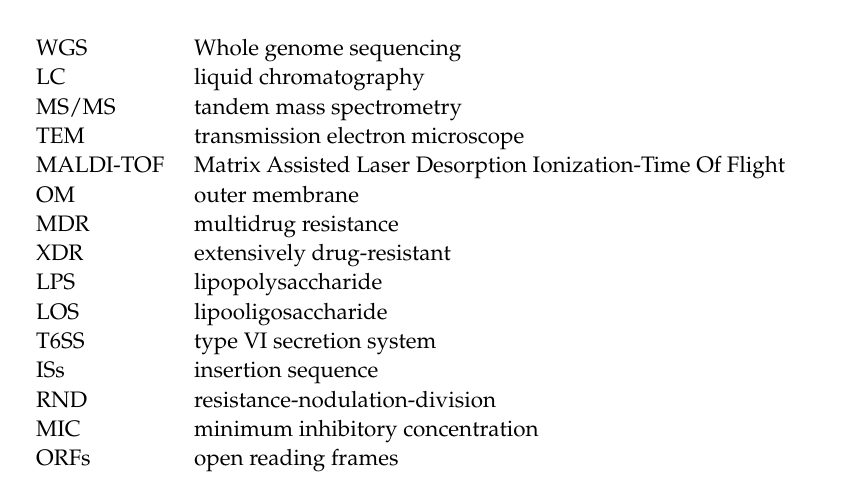
Supplementary Materials: The following are available online at https://www.mdpi.com/1422-006 7/22/2/576/s1, Table S1. Minimum inhibitory concentrations ( µ g/mL) of Ab-S and Ab-D subpopula- tions. Table S2. PLSDB analysis for plasmids in Ab-S and Ab-D subpopulations of A. baumannii . Table S3. ISs annotation by ISFinder Ab-S and Ab-D subpopulations of A. baumannii . Table S4. Proteins upregulated in Ab-D subpopulation in comparison to Ab-S. Fold changes were calculated with Ab-S as the reference category, which implies that values over 1 mean that a protein is upregulated in Ab-D. Table S5. Proteins downregulated in Ab-D in comparison to Ab-S. Fold changes were calculated with Ab-S as the reference category and values below 1 indicate protein downregulation in Ab-D. Supplementary Data File S1. The file contains Ab-S nucleotide sequence database. Supplementary Data File S2. The file contains Ab-D nucleotide sequence database. Supplementary Data File S3. The file contains Ab-S protein sequence database. Supplementary Data File S4. The file contains Ab-D protein sequence